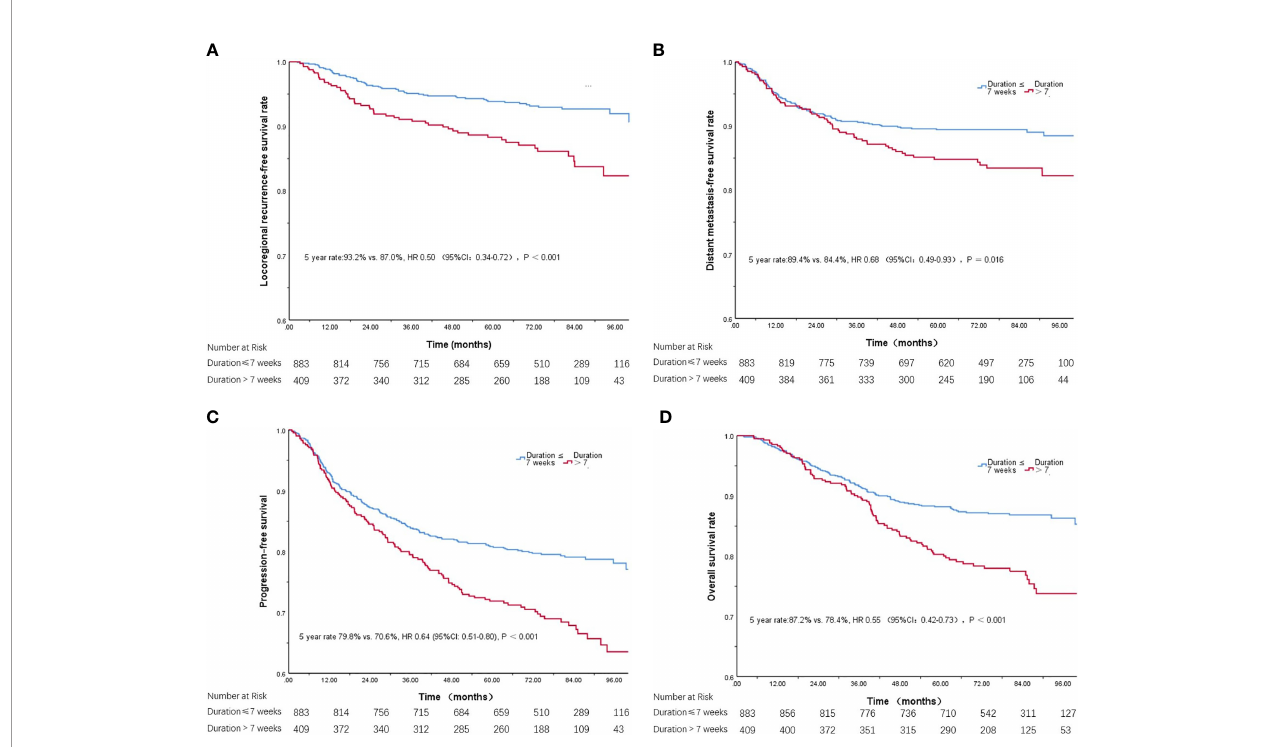
FIGURE 1 | Kaplan-Meier curves of locoregional recurrence-free survival (A) , distant metastasis-free survival (B) , progression-free survival (C) , and overall survival (D) , with radiation duration ≤ 7 weeks or >7